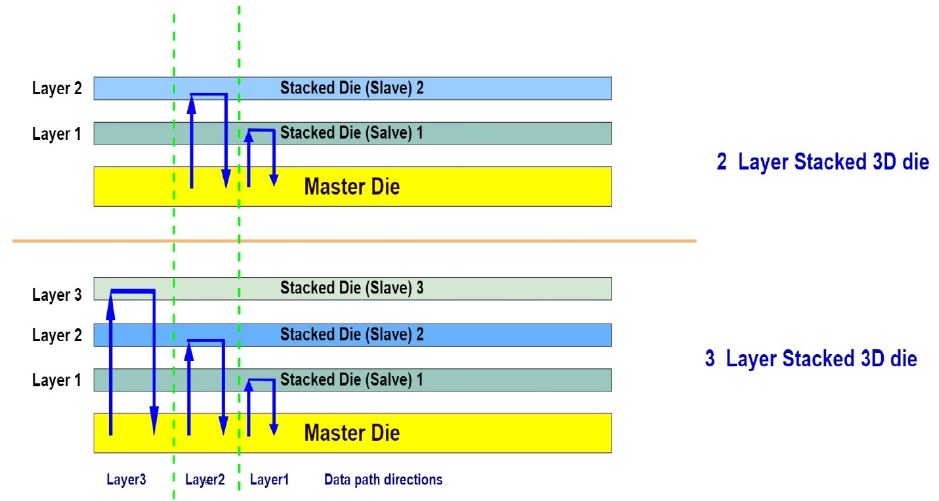
Figure 7. Write Group data paths in TSV with respect to multi-layer 3D SIC’s.